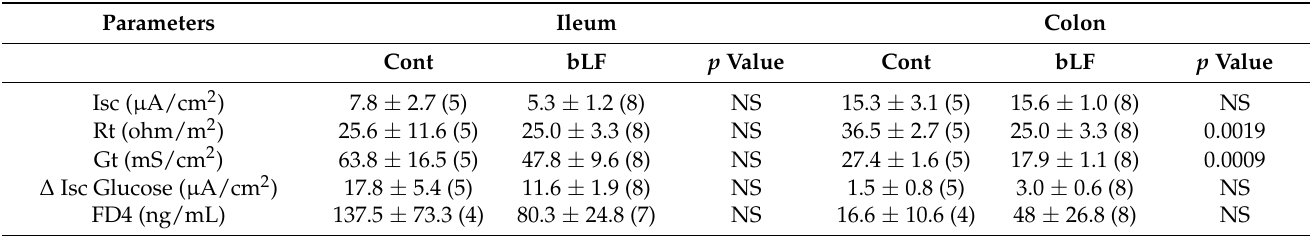
Table 4. Epithelial barrier characteristics in ileum and colon of pups recovered from mothers receiving the control diet or the bLF-supplemented diet. The parameters were determined at postnatal day 17.